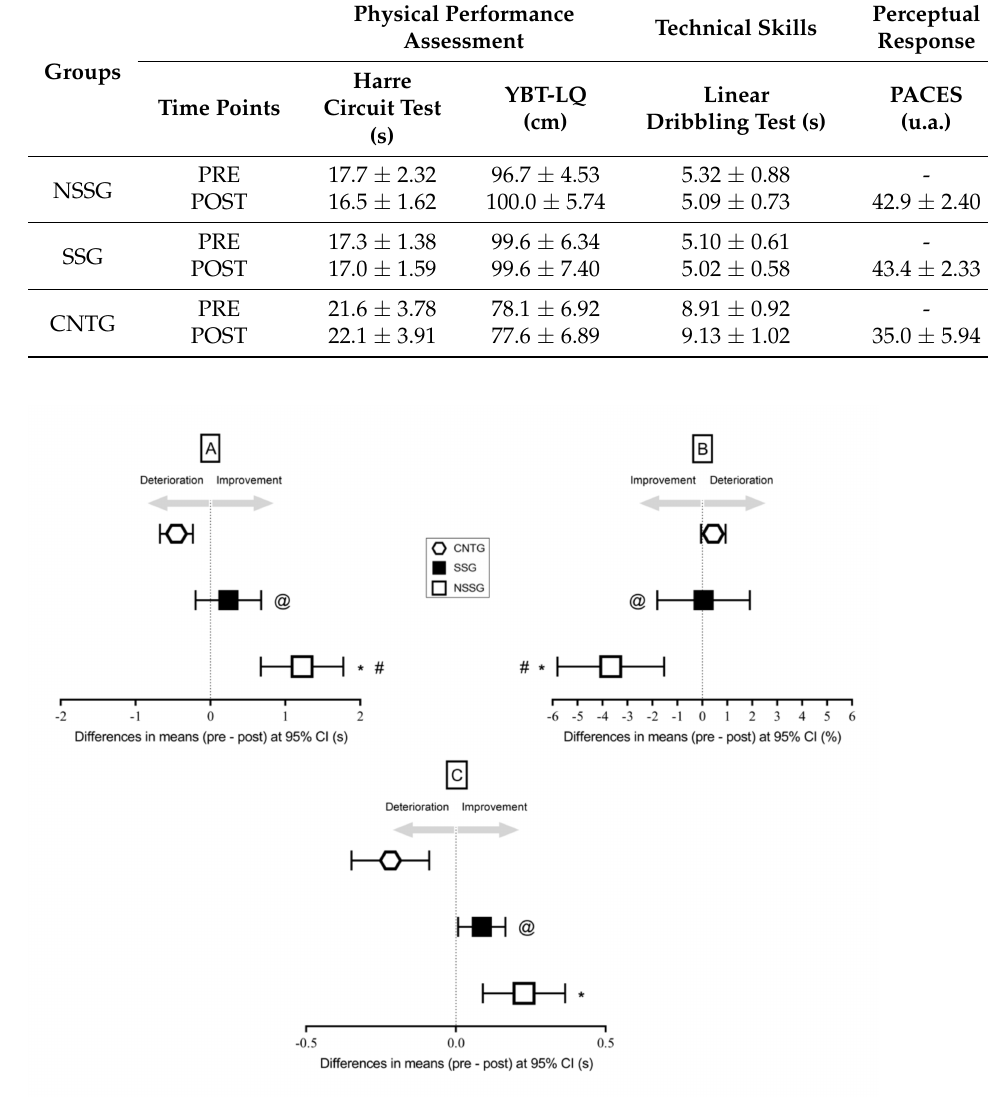
Figure 2. Graphical explanation of the pre-to-post difference with 95% confidence intervals (95% CI) for Harre test (panel ( A )), YBT-LQ (panel ( B )), and dribbling test (panel ( C )). * Significant ( p < 0.001) difference between NSSG and CNTG from post-hoc analysis. # Significant ( p < 0.05) difference between NSSG and SSG from post-hoc analysis. @ Significant ( p < 0.05) difference between SSG and CNTG from post-hoc analysis. Note: YBT-LQ = Lower Quarter Y-balance test, NSSG = non-sport- specific group, SSG = sport-specific group, CNTG = control